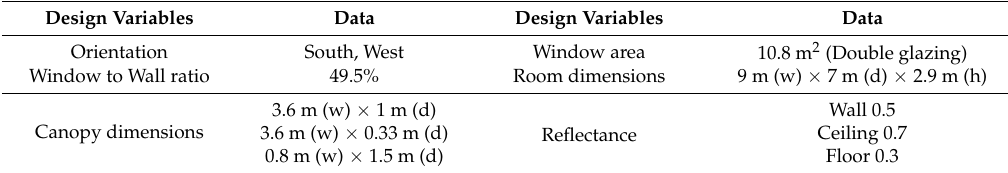
Figure 3. View of the standard classroom.